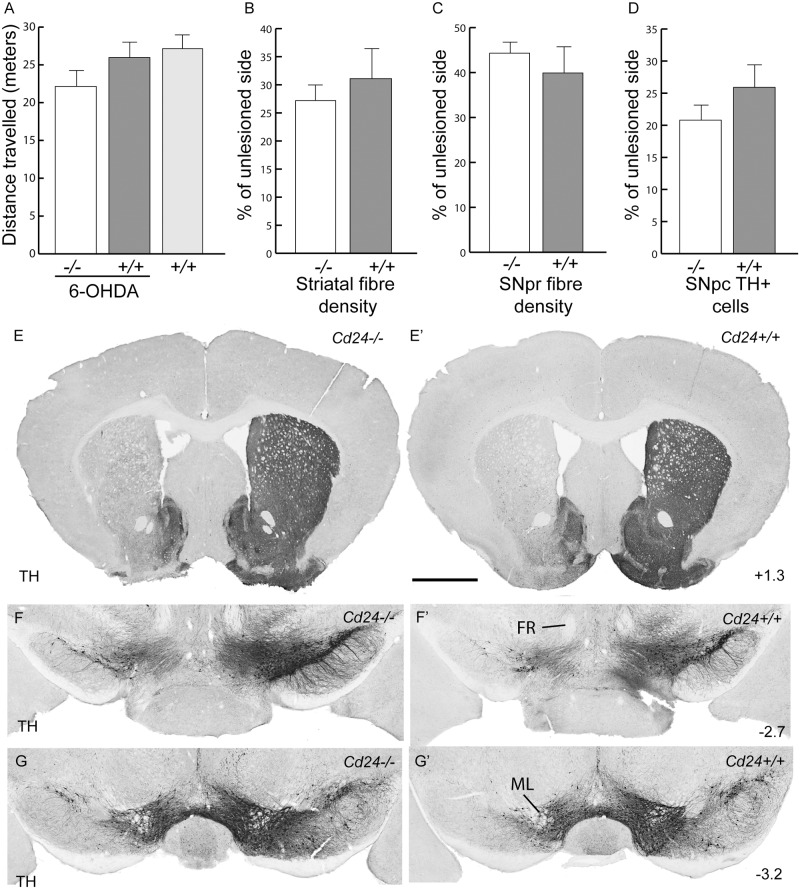
No difference in the long-term structural and functional integrity of the nigrostriatal pathway in the absence of Cd24 in the 6-OHDA mouse model of Parkinson's disease.(A) Distance travelled in the open field arena by 6-OHDA lesioned Cd24-/- and Cd24+/+ mice at 70 days post-surgery, compared to an unlesioned group of Cd24+/+ mice. (B) Optical density analysis of the TH+ fibres in the striatum indicated no difference between the genotypes. (C) Optical density analysis of the TH+ fibres in the SNpr also showed no difference between the genotypes. (D) Stereological estimations of the number of SNpc TH+ cells found no difference between the Cd24-/- and Cd24+/+ mice. (E) Coronal sections at the level of the striatum illustrating the unilateral loss of TH+ fibres in the Cd24-/- (left) and Cd24+/+littermate (right). (F) Coronal sections of the midbrain at the level of the fasciculus retroflexus (FR) demonstrating TH+ cell loss in the rostral SNpc of the Cd24-/- (left) and Cd24+/+ littermate (right). (G) Sections of midbrain at the level of medial lemniscus (ML) intersecting the VTA and SNpc illustrating TH+ cell loss. Co-ordinates in the corners of panels E, F and G indicate location of the coronal plane relative to bregma. The scale bar in panel E represents 1cm in panel E, and 600μm in panels F and G.